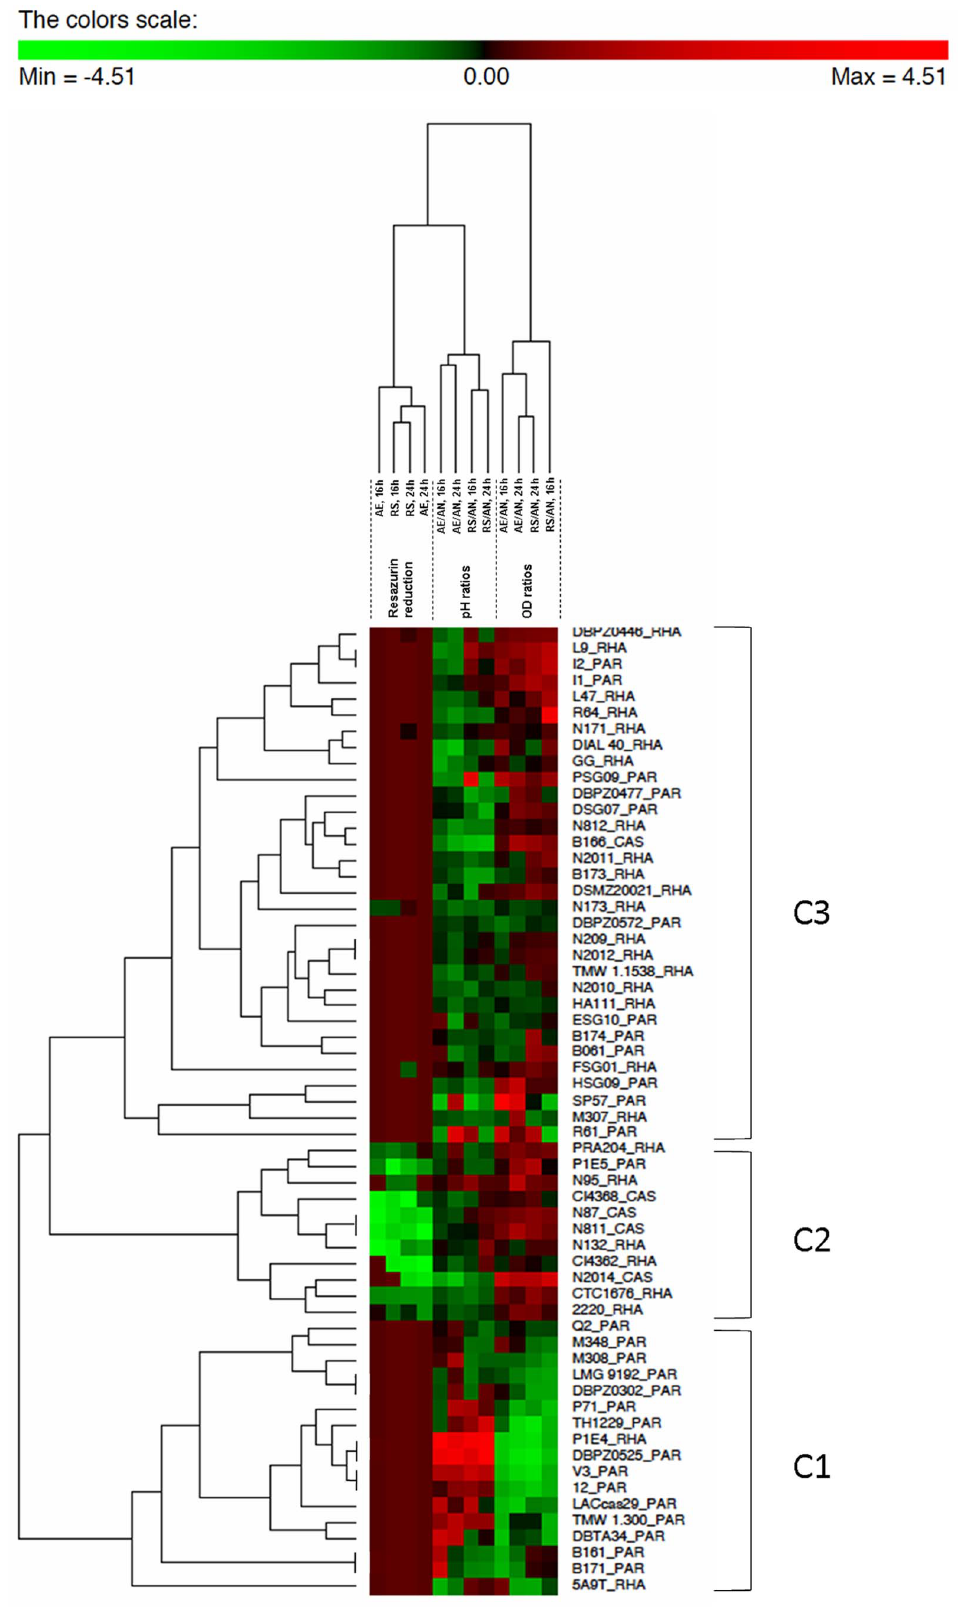
Figure 4. Matrix Hierarchical Cluster Analysis obtained with PermutMatrix program v. 1.9.3 (LIRMM, France). z-transformation of the dataset, Pearson r correlations and Average linkage (UPGMA) method were used to perform clustering. Column dendrogram: time of resazurin